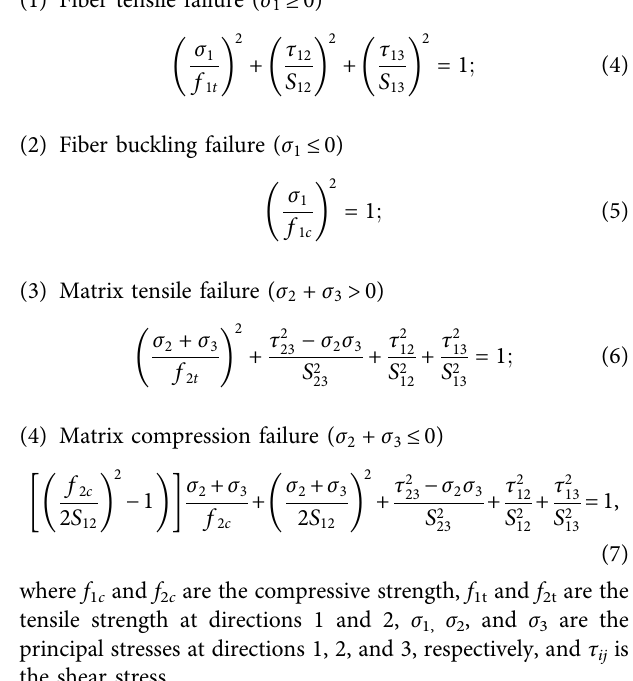
Frontiers in Materials |